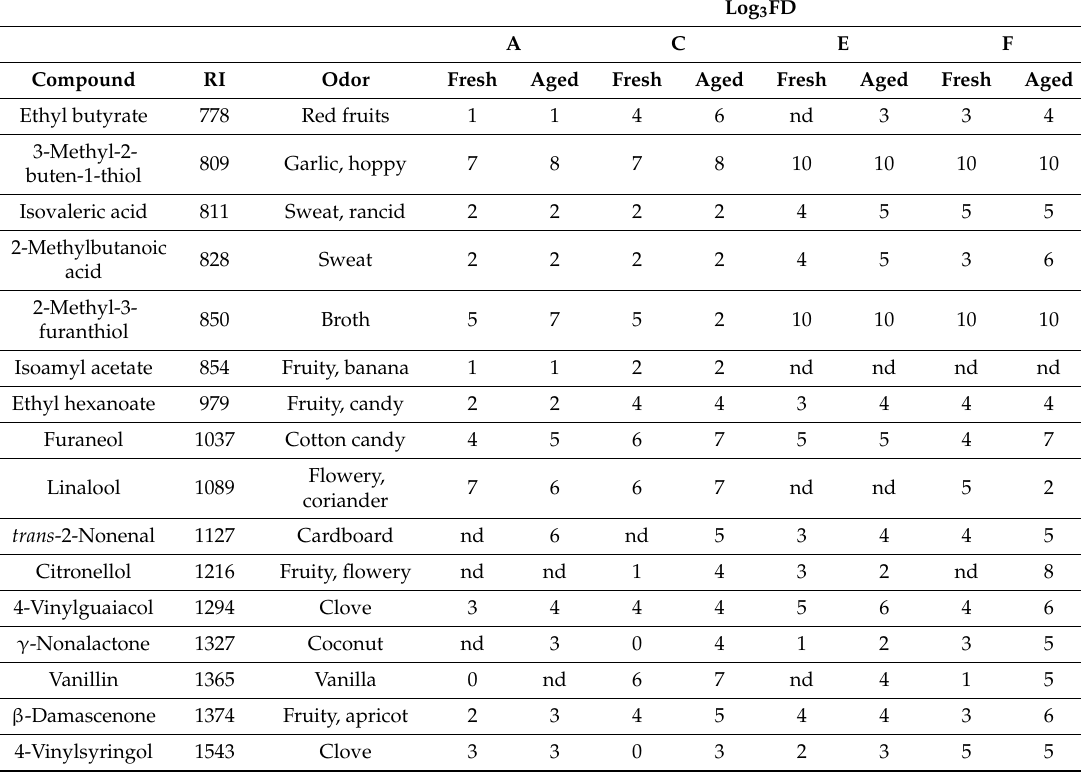
Table 2. GC-olfactometric analysis of XAD-2 extracts issued from beers A, C, E, and F (fresh and after 6 months of storage at 20 ◦ C). RI: retention index; nd: not